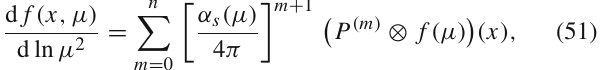
text. On the left, we use the same grids as in Fig. 1, with n pts = 63 for Chebyshev interpolation and n pts = 64 for L-splines. On the right, we use the Chebyshev grid [ 10 − 9 , 0 . 2 , 1 ] ( 40 , 32 ) with n pts = 71 and for L-splines a grid with n pts = 150 (corresponding to the NNPDF3.1 grid in Table